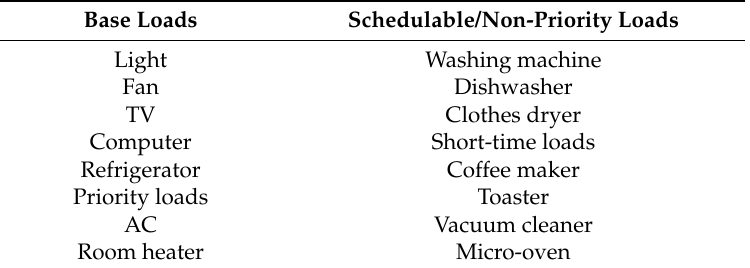
Table 1. Load categories for load controller.